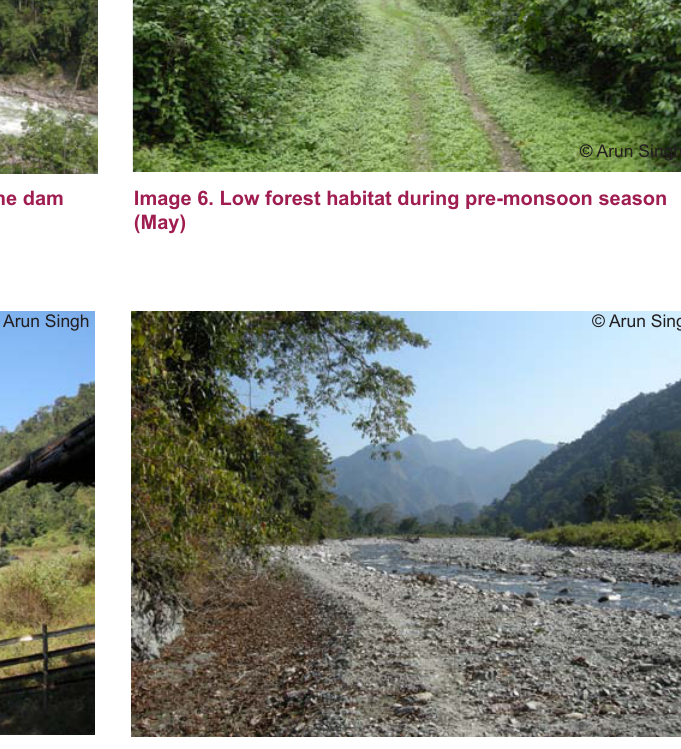
Image 7. Huma Village Image 8. Hama Khola (riverlet) during winter